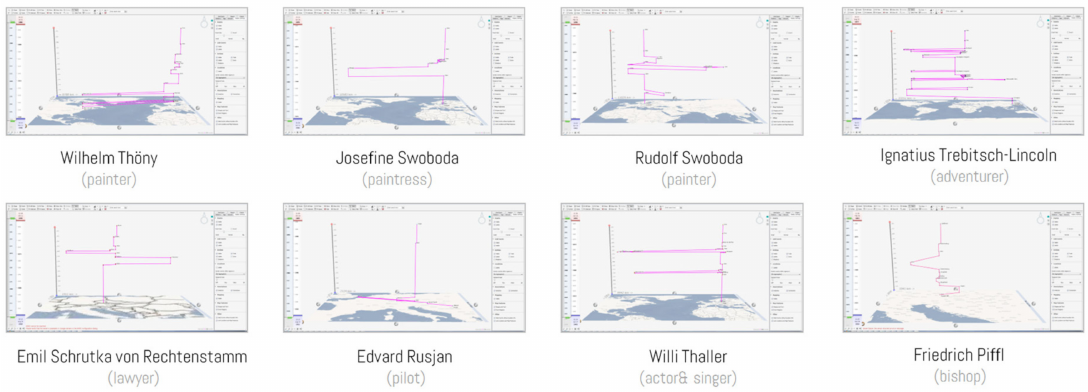
Figure 6. Comparatistic visualization of eight biographical narratives, as extracted from the APIS